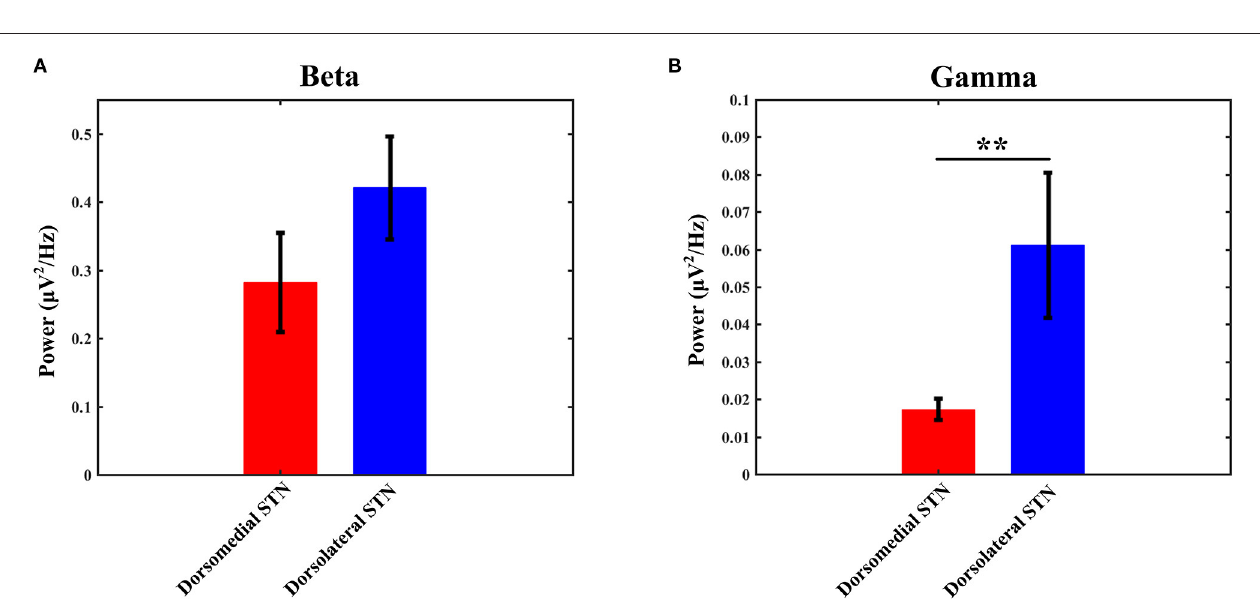
( Figure 4B , p < 0.05). The mean value of gamma coherence in the dorsomedial group was 0.128 ± 0.016, and the same measure in the dorsolateral group was 0.237 ±